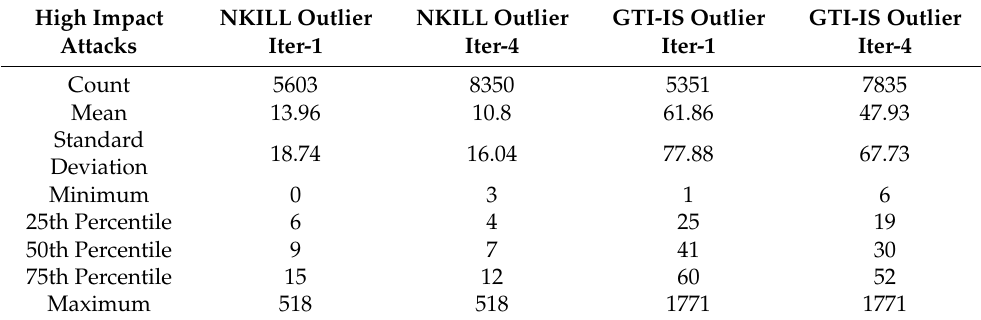
Table 3. IOA iteration details for nkill and GTI-IS values using the proposed IOA algorithm. High Impact